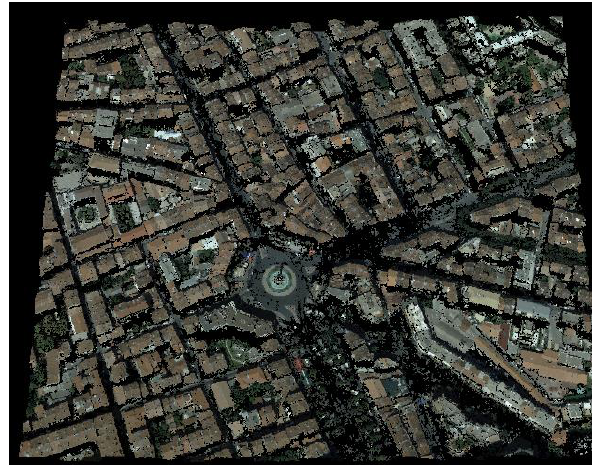
Figure 13. Dense point cloud, 25 million points